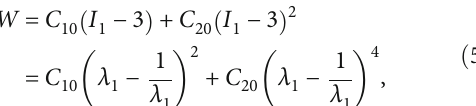
Figure 3: Expansion equivalent